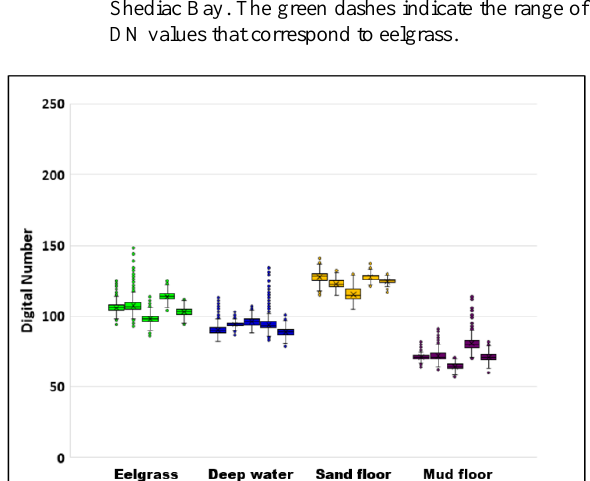
Figure 5: Channel 2 (green band) comparison of the DN values for the four classes in the Pix4D RGB mosaic of Shediac